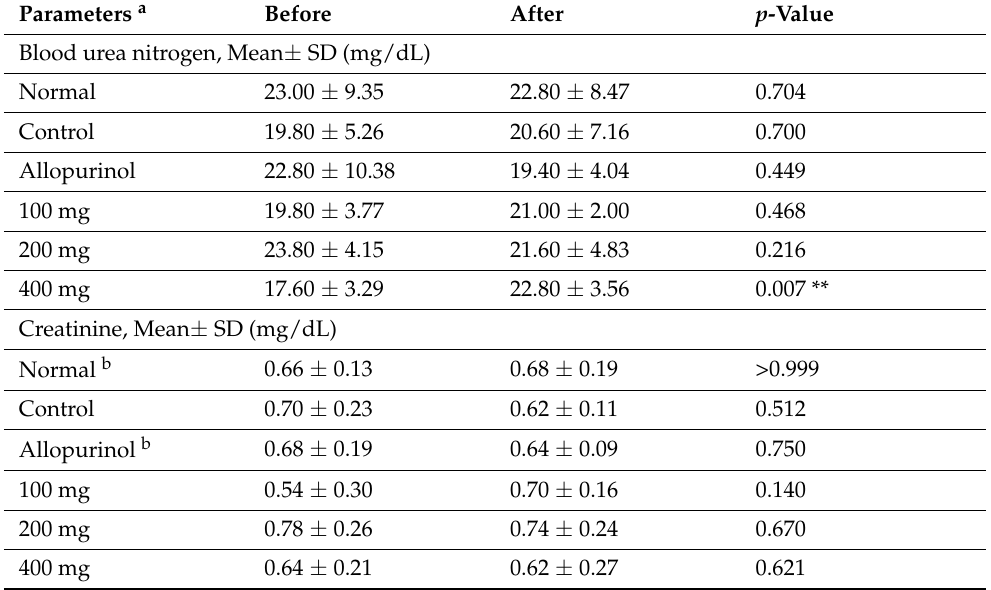
Table 3. Levels of blood urea nitrogen and creatinine before and after the intervention.